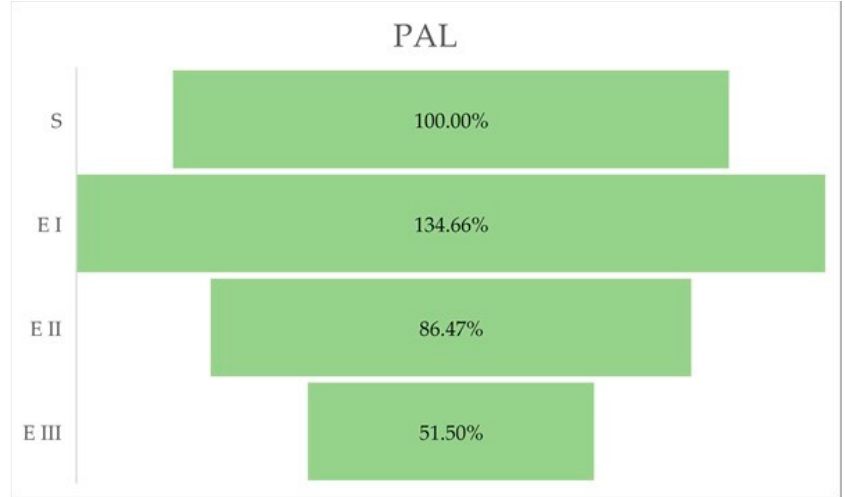
Figure 4. PAL activity (%) in different stages of the disease. Legend: S–healthy palm oil; E I–stage I of bud rot disease infection in oil palm; E II–stage II of bud rot disease infection in oil palm; E III– stage III of bud rot disease infection in oil palm.